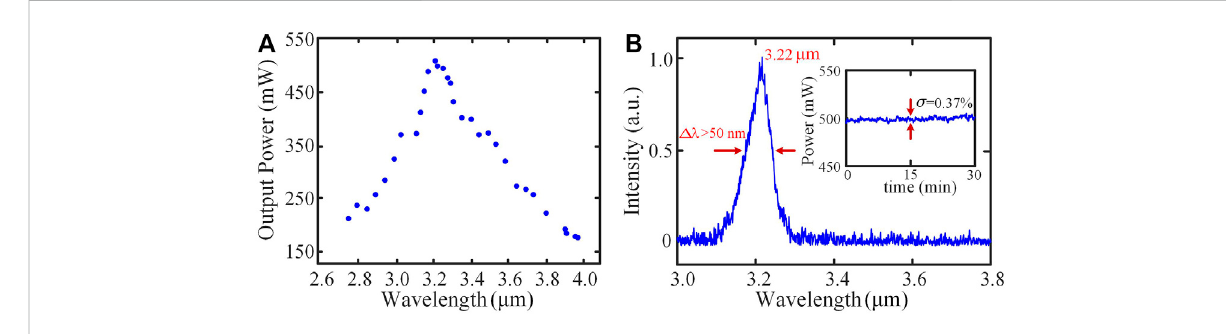
Figure 2A, via using an optical spectrum analyzer (AQ6370D, Yokogawa), the measurement wavelength was centered at 1,032.5 nm with a 3-dB bandwidth of 0.28 nm. As depicted in Figure 2B, after ampli fi cation by cascaded gain fi ber, the spectrum was broadened due to the in fl uence of self-phase modulation (SPM), and the corresponding 10-dB bandwidth was 10 nm. Note that the highest power was at about 1,037 nm. Figure 2C gives the performance of the ampli fi er, it can be seen that the maximum output power reached 6.2 W at 16 W pump power. The corresponding pulse duration of 18 ps can be deduced from the measured autocorrelation trace by an autocorrelator (PulseCheck, APE), as illustrated in Figure 2D. In Figures 2E,F, via using an oscilloscope (MDO3032, Tektronix) and an RF spectrum analyzer (MDO32, Tektronix), we measured the time interval between adjacent pulses and pulse repetition rate of 63.2 ns and 15.8 MHz, respectively. The RF spectrum was very clean with a signal-to-noise ratio of 52 dB (RBW = 100